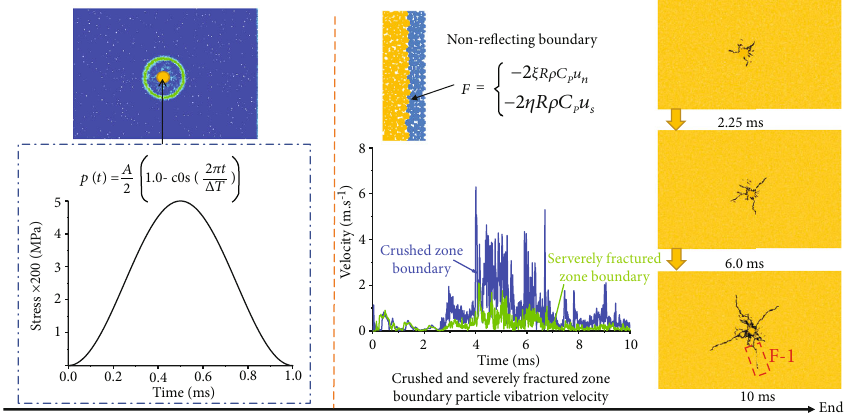
Figure 2: Blasting simulation method